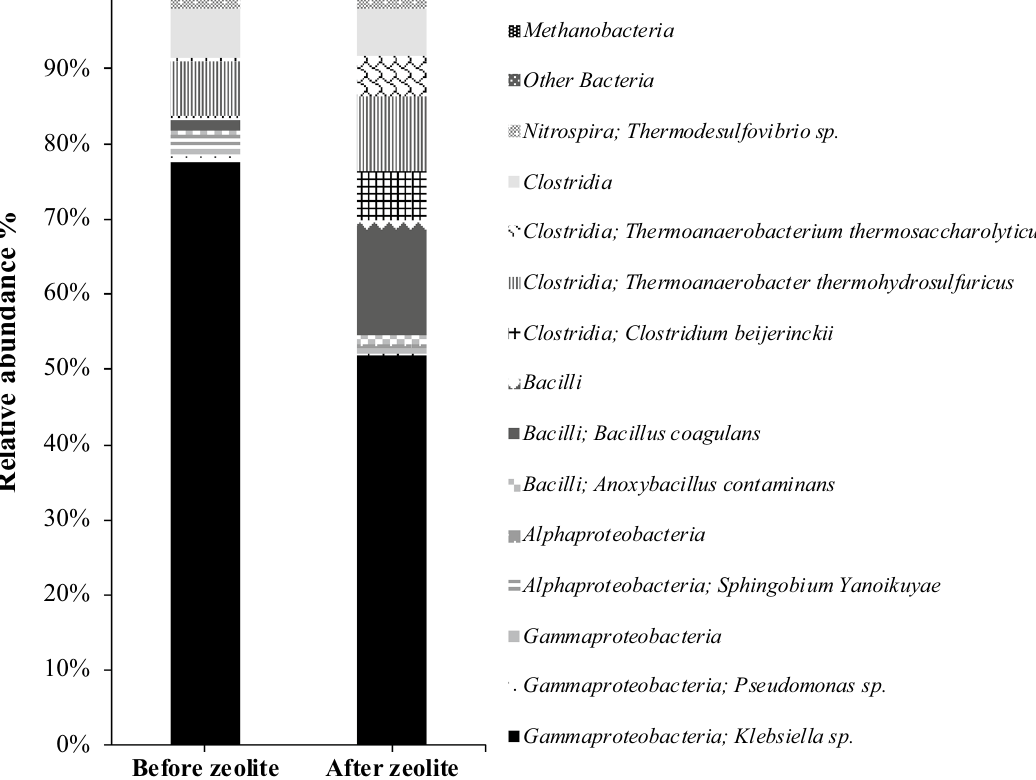
Figure 4. Microbial community composition in the bioreactor treating arabinose and glucose. Only the class and specie of the microorganisms with relative abundance above 1% are